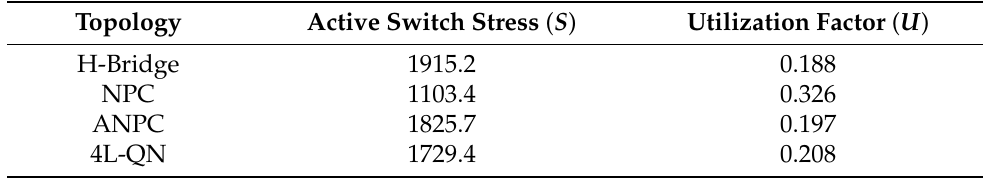
Table 3. Switch stress and utilization.